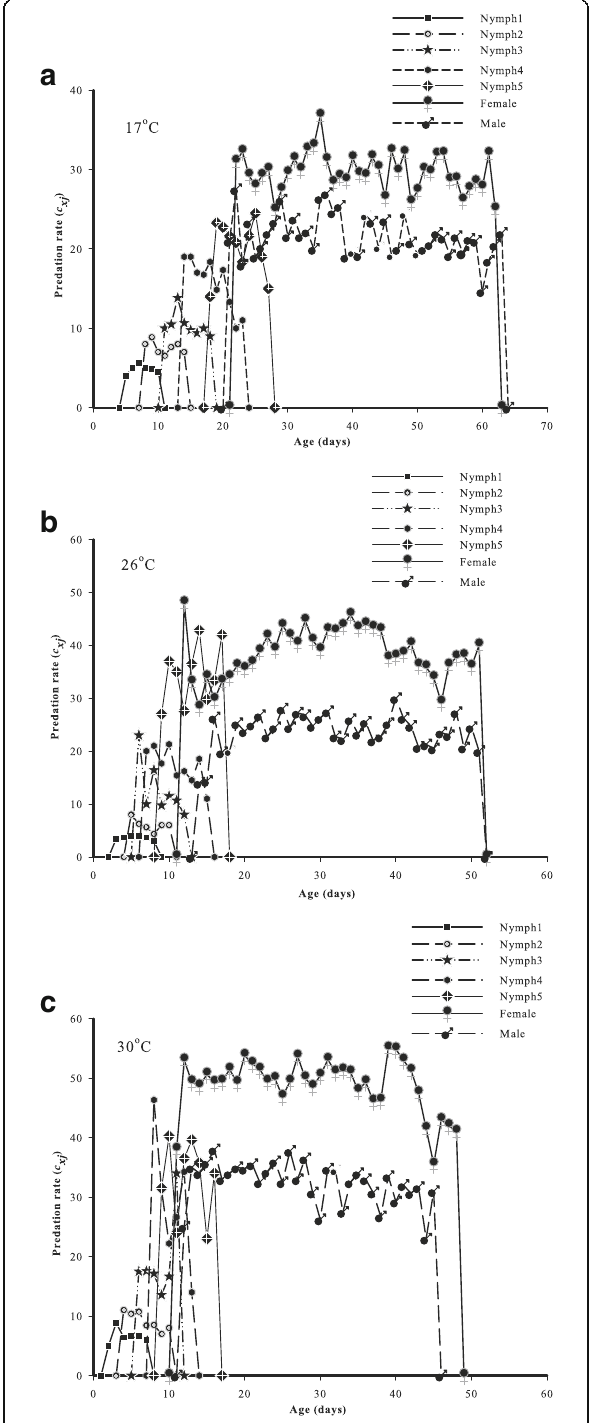
Fig. 2 The age-stage predation rate ( c xj ) of Anthocoris minki pistaciae fed with Agonoscena pistaciae at three different temperatures under laboratory conditions. c xj , the age-stage- specific predation rate of different life stages of Anthocoris minki pistaciae feeding on Agonoscena pistaciae nymphs at three different temperatures. a 17 °C. b 26 °C. c 30